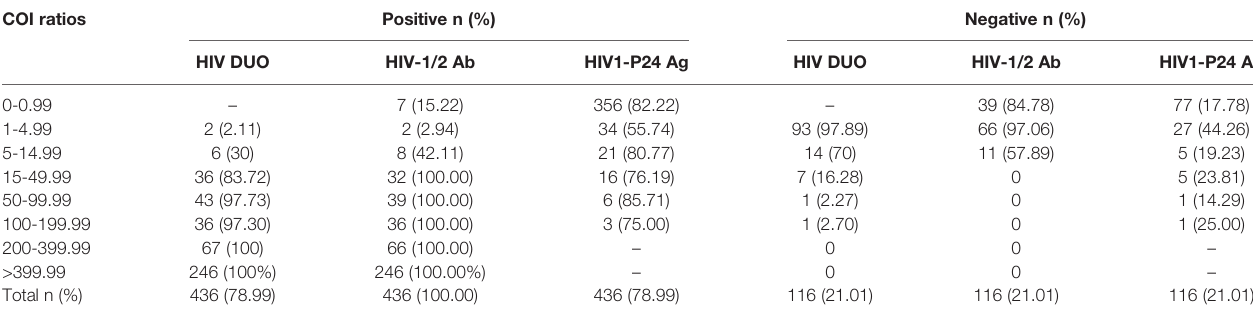
TABLE 3 | Results of all 552 WB or subsequent supplementary test-con fi rmed individuals in relation to cutoff index (COI) ratios. COI ratios Positive n (%) Negative n (%) HIV DUO HIV-1/2